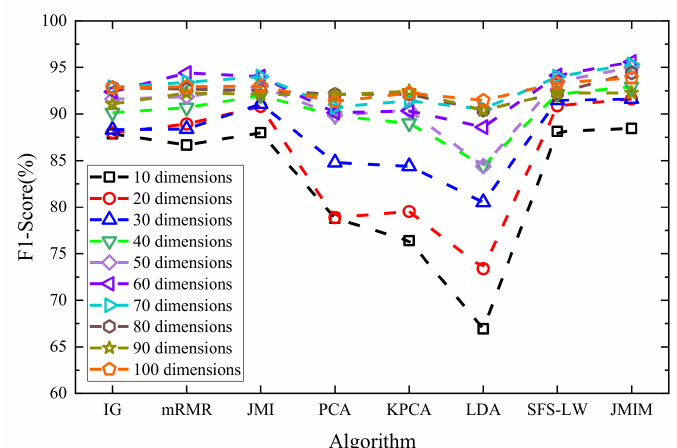
Figure 12. Performance comparison of different feature-selection